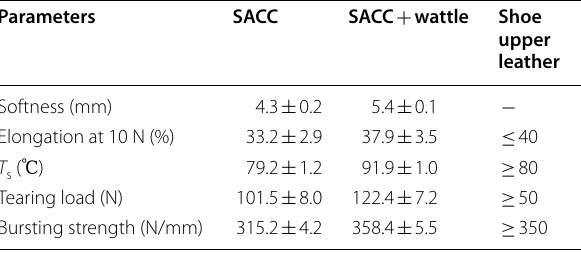
Table 1 The physical properties of the leathers. The value on the shoe upper leather suggests the Chinese standard requirements (QB/T 1873-2010) Parameters